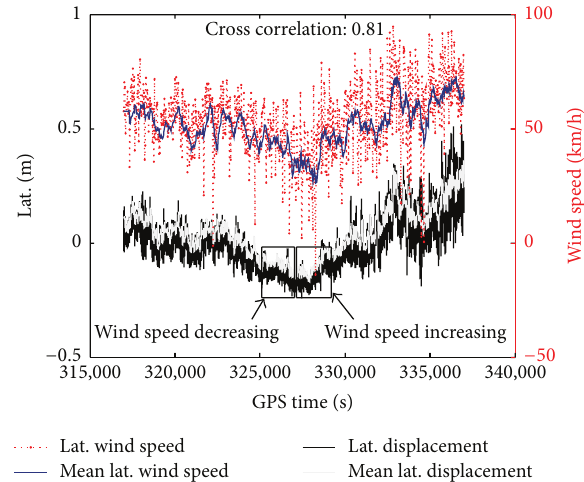
Figure 13: The wind speed resolved to BCS and the corresponding deflection. Figure 14: Lateral displacement and wind speed during the abrupt wind speed changing